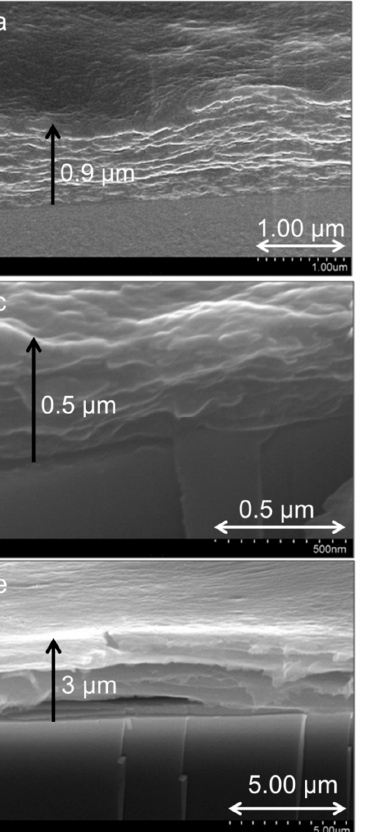
Figure A2. SEM cross-section images of ( a ) PDDA-Laponite 80 layers, ( b ) PDDA-Laponite 360 layers, ( c ) PDDA-PSS-PDDA-Laponite 80 layers, ( d ) PDDA-PSS-PDDA-Laponite 180 layers, ( e ) PDDA-PAA-PDDA-Laponite 80 layers, and ( f ) PDDA-PAA-PDDA-Laponite 180 layers. Lines with arrows indicate the thickness of the film deposited on the substrate.